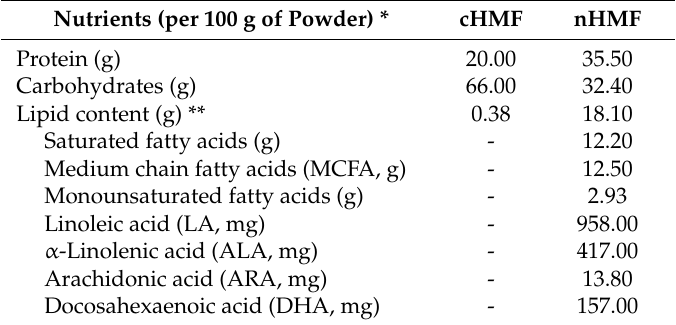
Table 1. Nutritional composition of the control (cHMF) and new human milk fortifier (nHMF). Nutrients (per 100 g of Powder) *